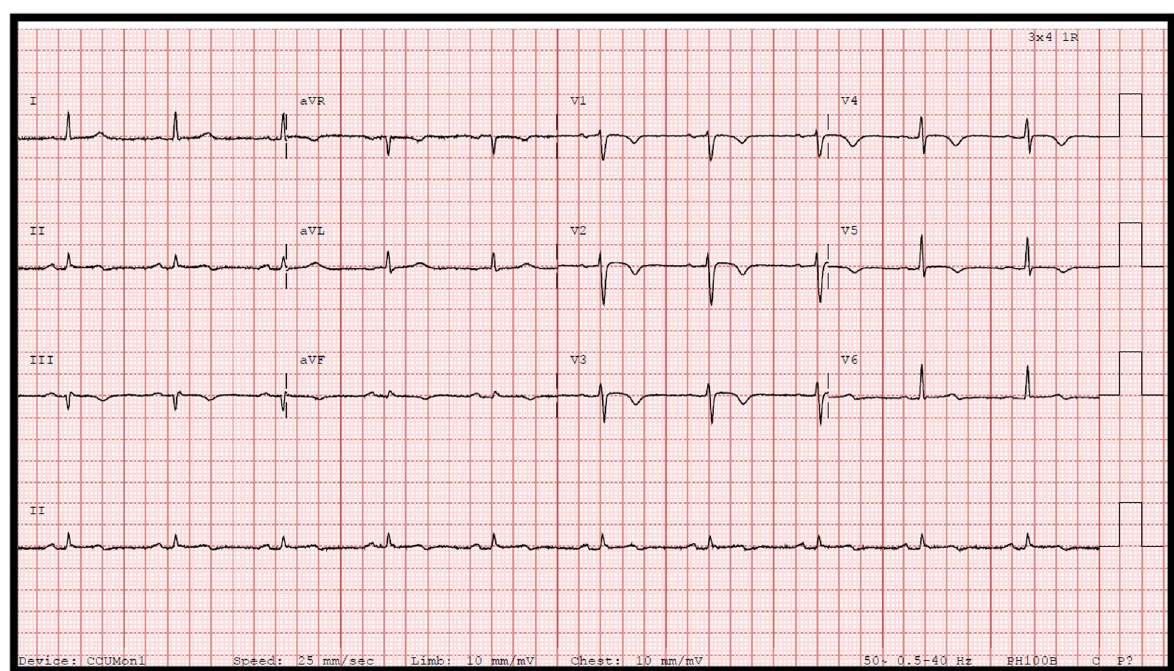
Fig. 9 ECG showing TWI anteriorly post-coronary angiogram—Courtesy Dr Riley Batchelor